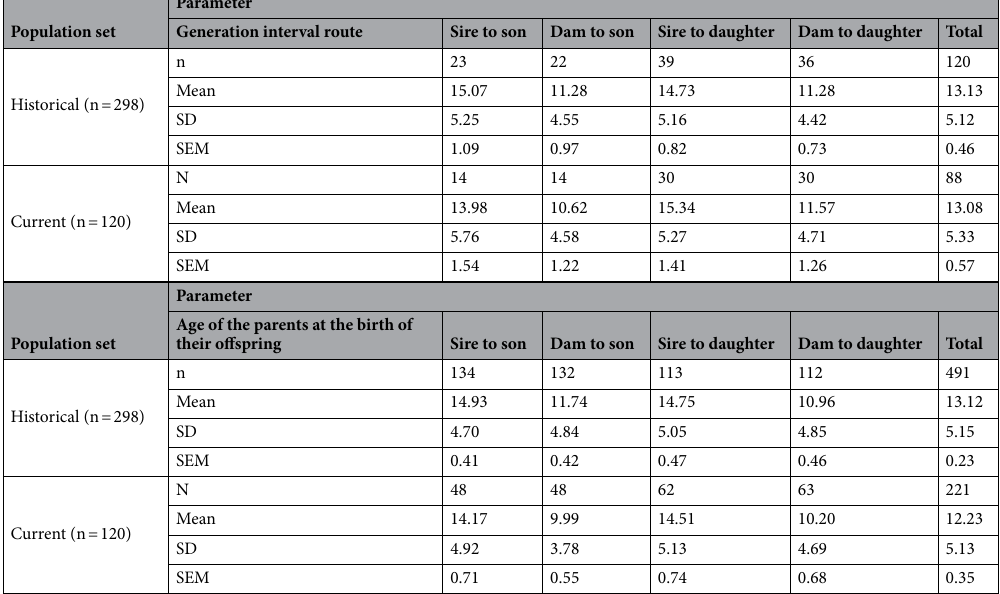
Populational sets Historical (n = 298) Current (n =